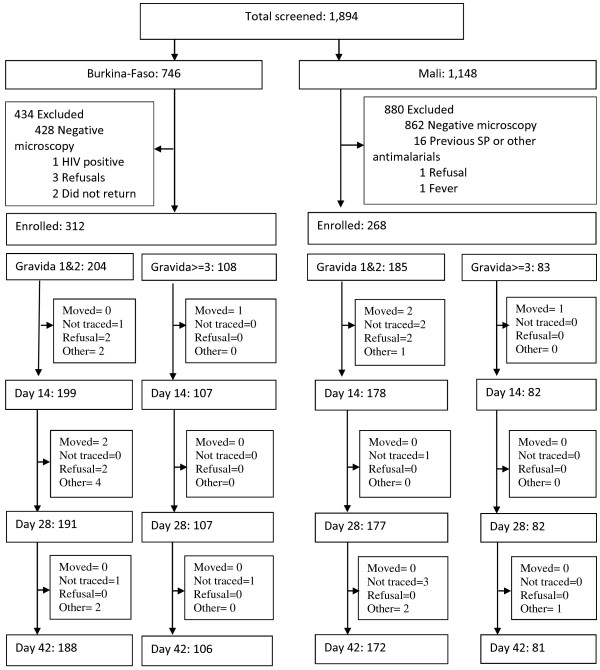
Study flow chart.